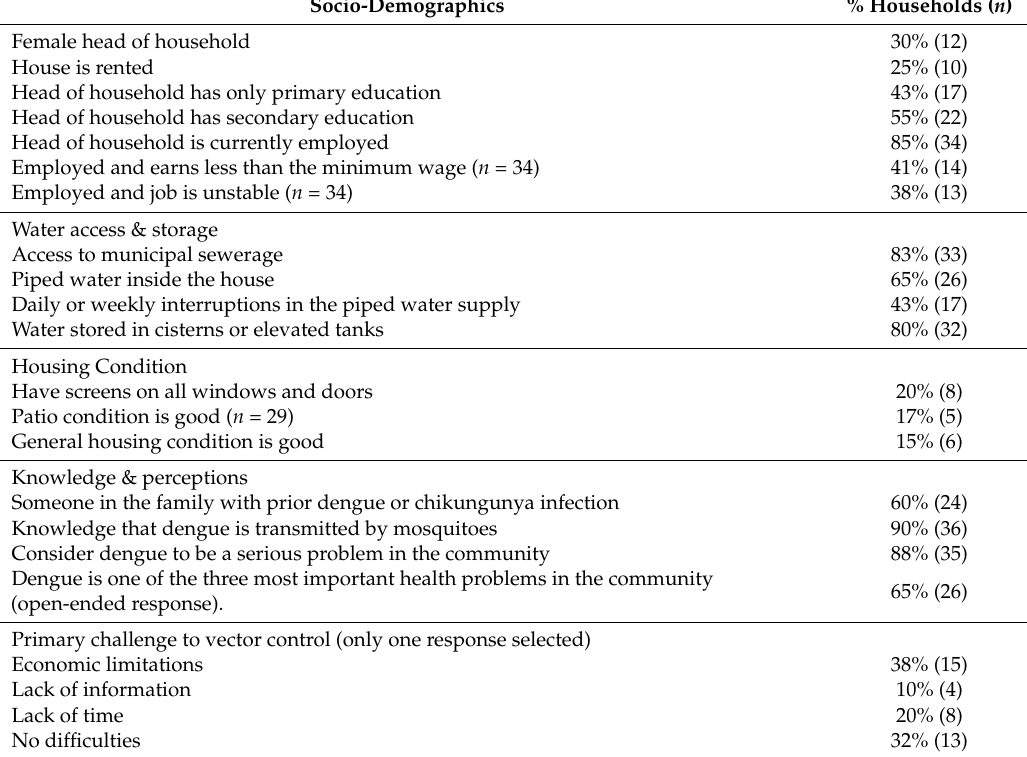
Table 1. Socio-demographic information from survey respondents ( n =